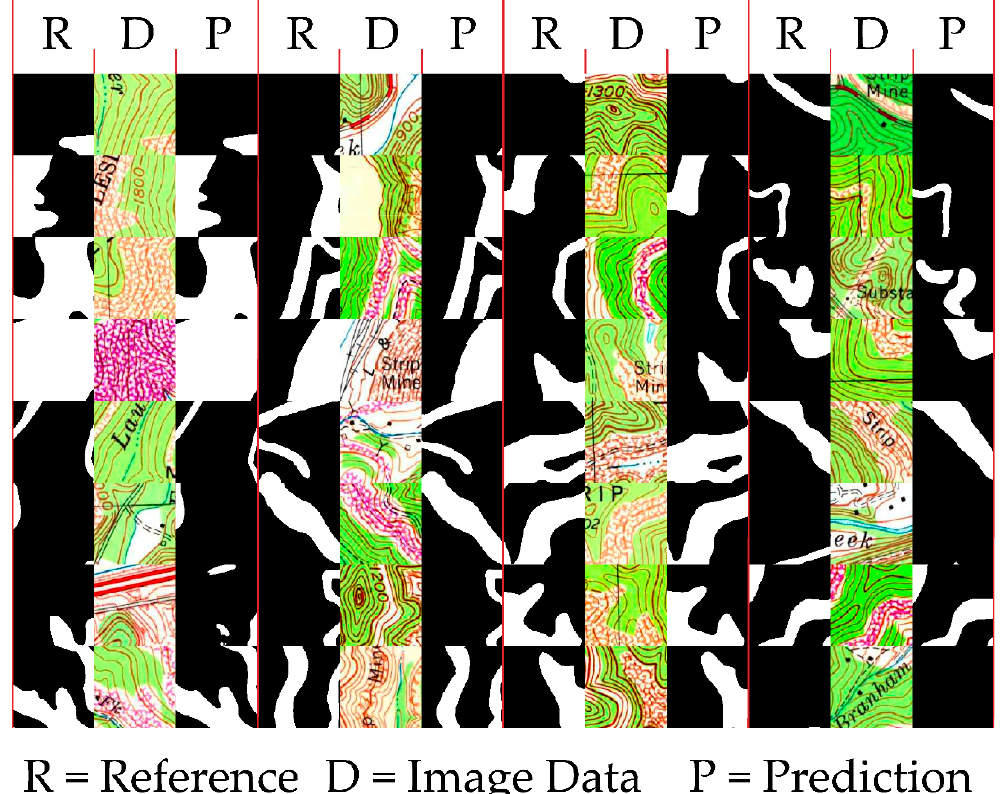
Figure 7. Reference labels, image data, and classification results for 36 randomly selected image chips from the KY Validation set. Topographic maps obtained from the USGS and the National Map’s Historical Topographic Map Collection.